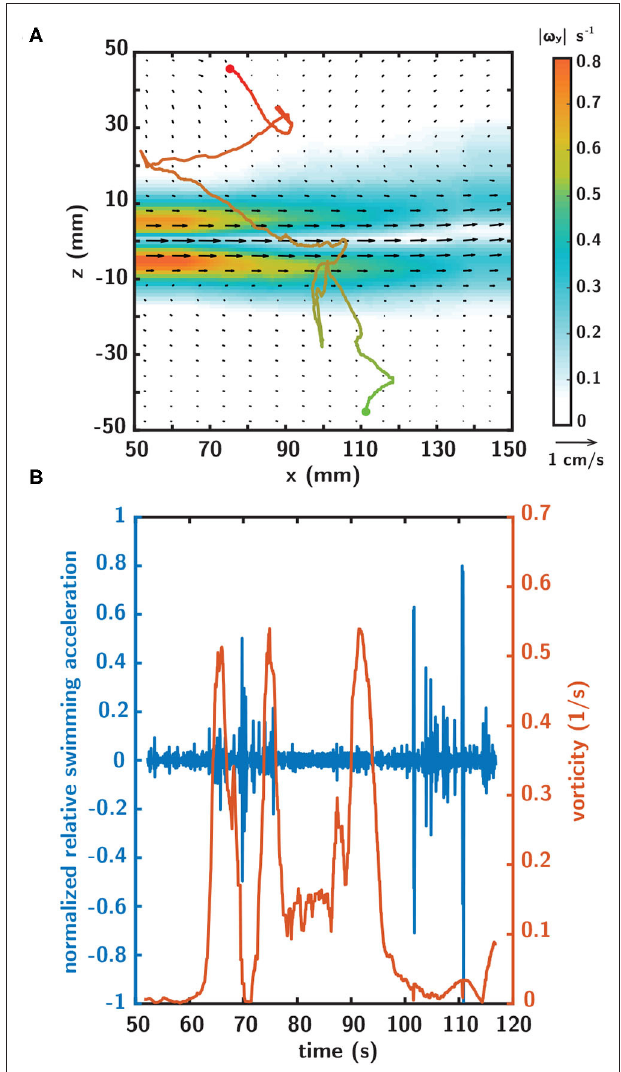
FIGURE 8 | (A) A representative larval swimming trajectory in the horizontally-oriented shear flow as denoted by the velocity vectors (black) and vorticity magnitude contours. The starting and ending points of the trajectory are indicated by the green and red dots, respectively, and the corresponding color gradient indicates the temporal progression of the trajectory. (B) Corresponding timeseries of normalized relative swimming acceleration (blue) and fluid vorticity (orange) over the trajectory